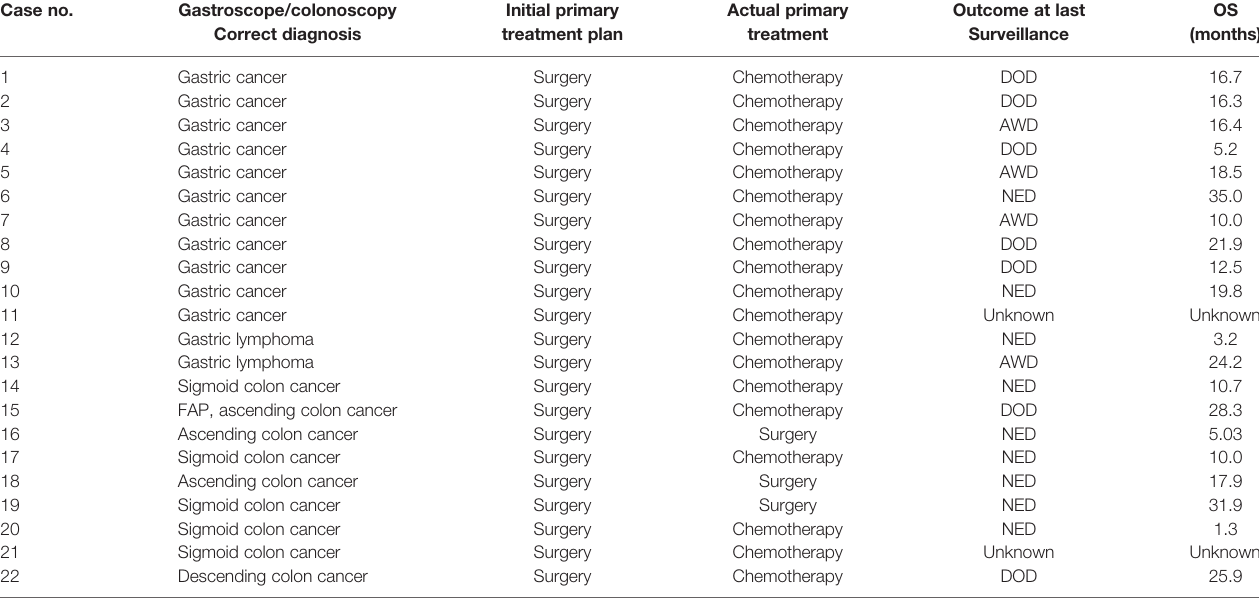
TABLE 3 | The treatment and prognosis of the 22 ovarian metastases from the stomach or colon. Case